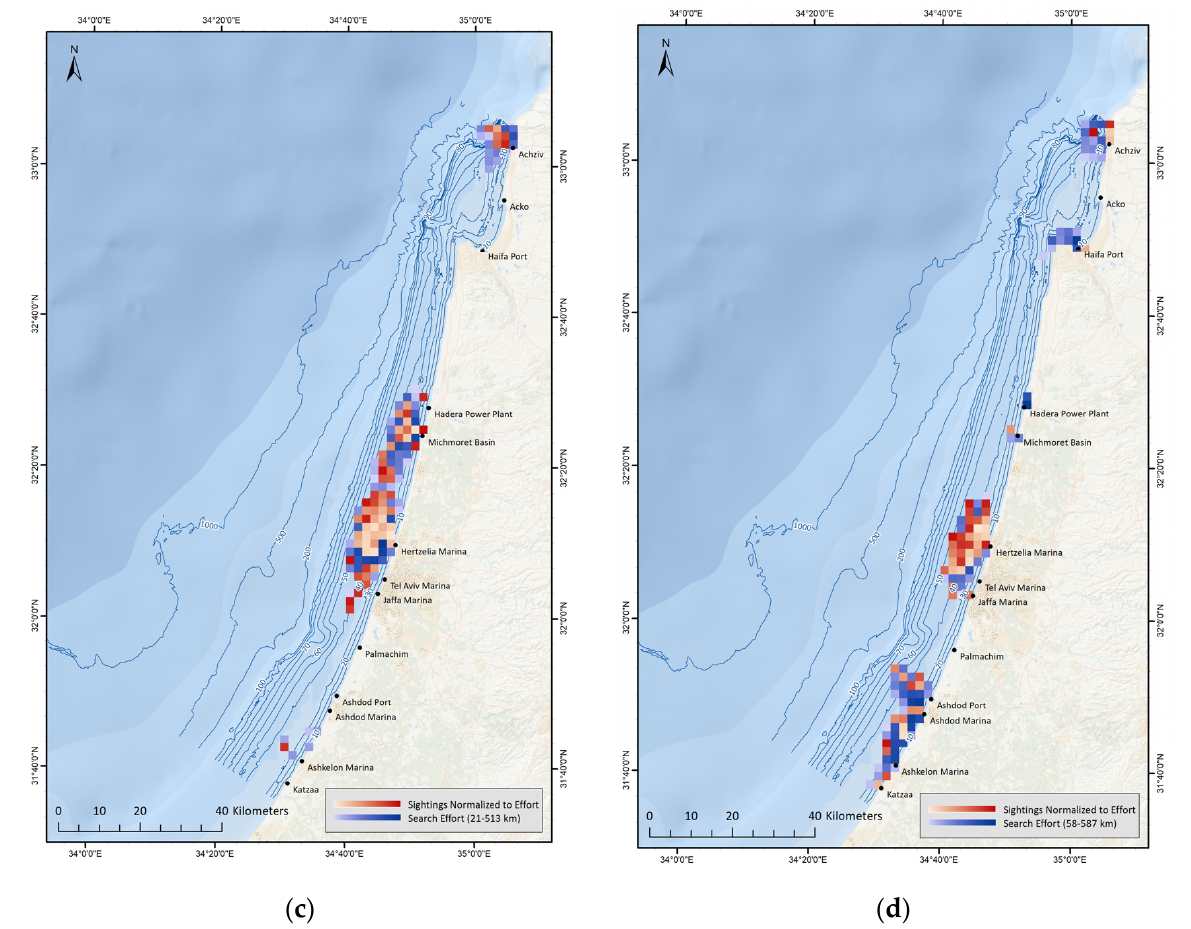
Figure 2. ( a ) Map displaying all sightings from surveys along the Israeli Mediterranean coast between 1999 − 2020, with the two shades of pink representing T. truncatus sightings, before and after the year 2013; ( b ) Map displaying distribution of survey effort between 1999 − 2020. Each square in the grid represents a 2 km × 2 km area in which total length of vessel tracks across the entire time period was summed; ( c ) Map of study area, displaying survey effort and T. truncatus sightings (normalized to survey effort), presenting only grid-cells with sufficient survey effort to surpass the correlation threshold, during the years 1999 − 2009; ( d ) Map of study area, displaying survey effort and T. truncatus sightings (normalized to survey effort), presenting only grid-cells with sufficient survey effort to surpass the correlation threshold, during the years 2010 −